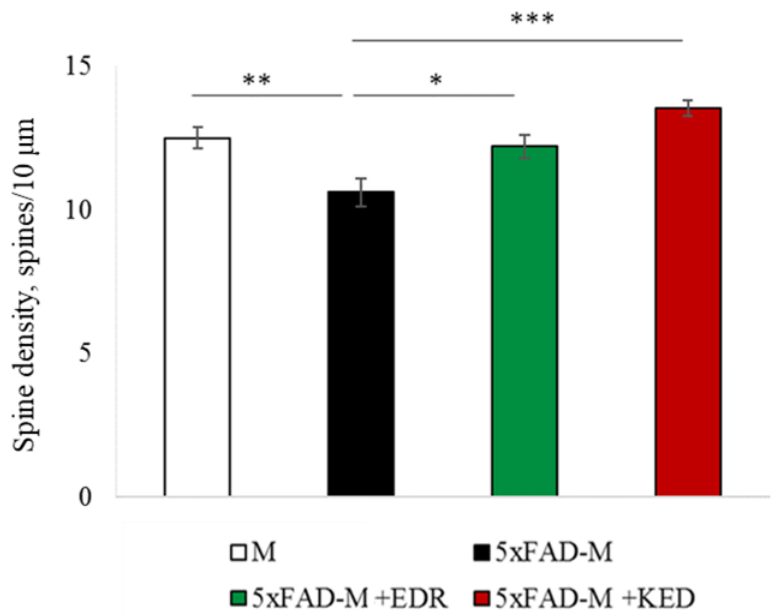
Figure 5. Confocal images of the CA1 secondary dendrites in 5 month-old male M-line ( a ) and 5xFAD-M mice, injected with a physiological solution ( b ), EDR peptide ( c ), KED peptide ( d ). Con- focal microscopy, ×100. Scale bar, 10 μm.